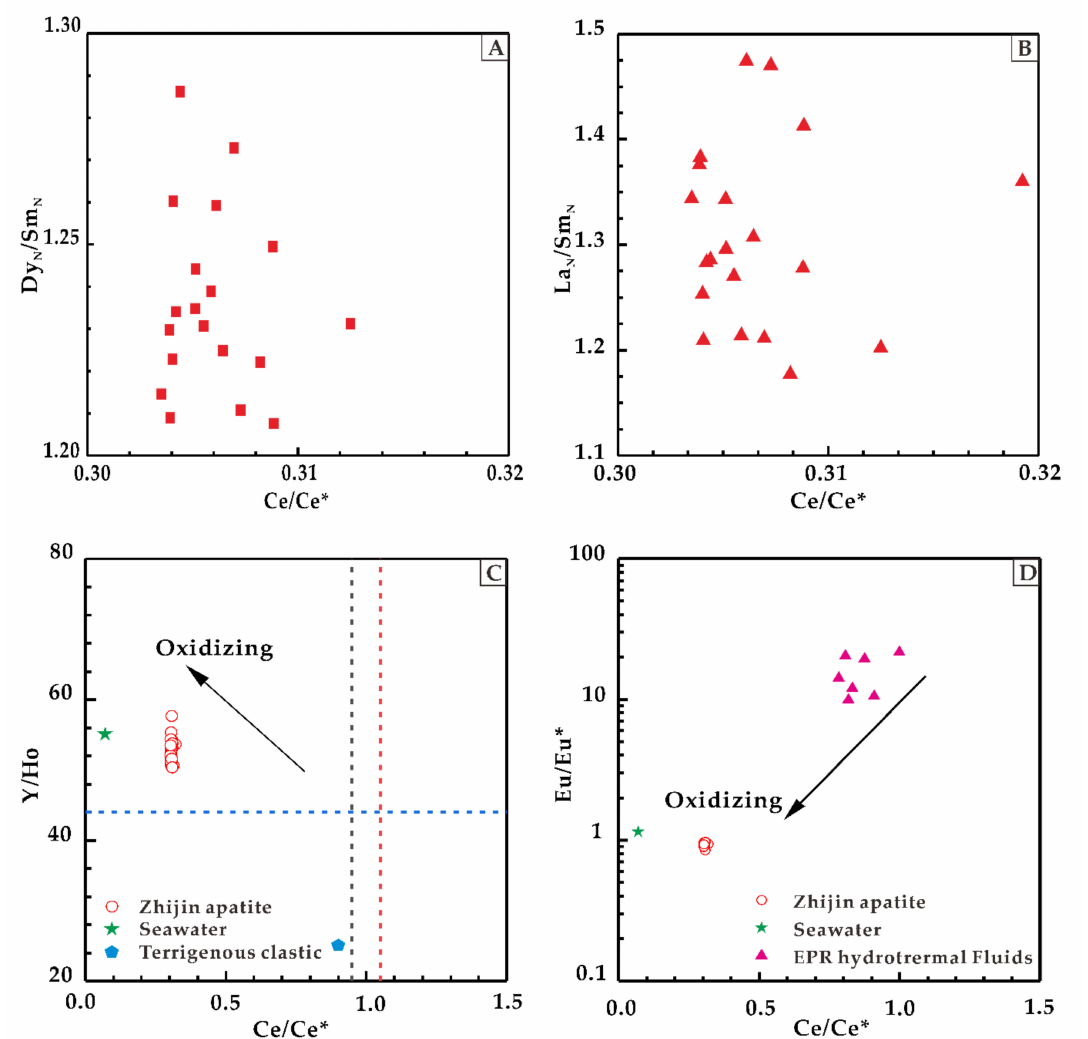
Figure 7. ( A ) No correlation between Dy N / Sm N and Ce / Ce*; ( B ) no correlation between La N / Sm N and Ce / Ce*; ( C ) cross-plot of Ce / Ce* vs. Y / Ho; ( D ) cross-plot of Ce / Ce* vs. Eu /